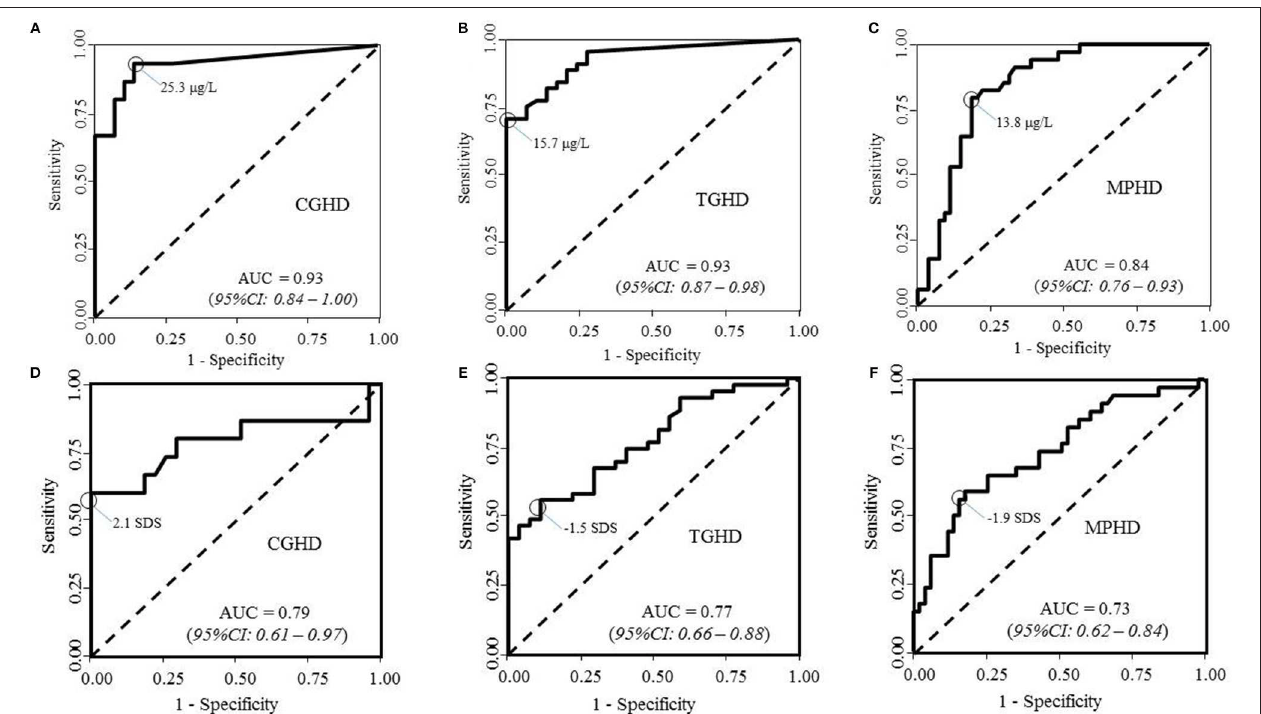
FIGURE 3 | ROC curve analyses of peak GH after GHRHarg and IGF-I SDS in (A,D) patients with congenital growth hormone deficiency (CGHD, A,D ), tumoral GHD (B,E) , and (C,F) multiple pituitary hormone deficiency (MPHD).